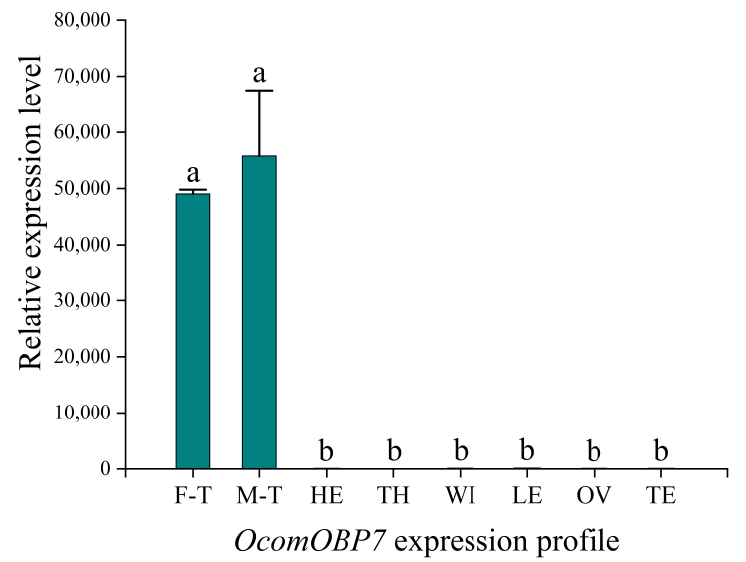
Figure 2. Expression profiles of OcomOBP7 . F-T: female antennae; M-T: male antennae; HE: head; TH: thorax; WI: wing; LE: leg; OV: ovary; TE: testis. All values are shown as the mean ± SD. Different letters indicate significant differences at p < 0.05 by LSD test.